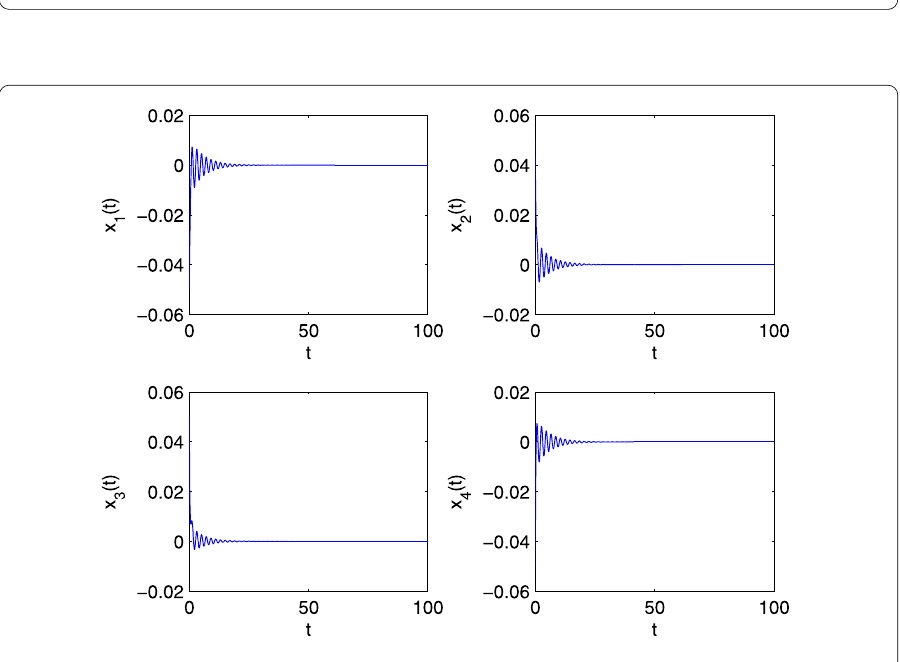
Figure 14 State response of system (5.4) with φ = 0.96, τ = 0.22 < τ 0 =